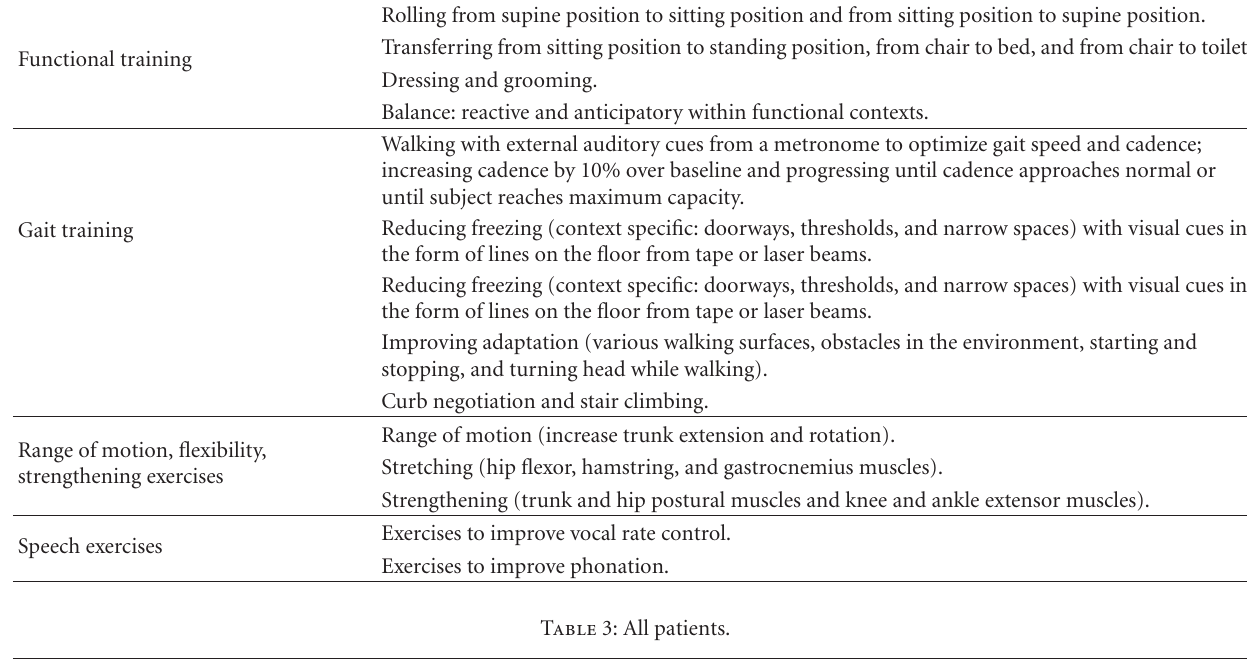
Table 2: Description of interventions.